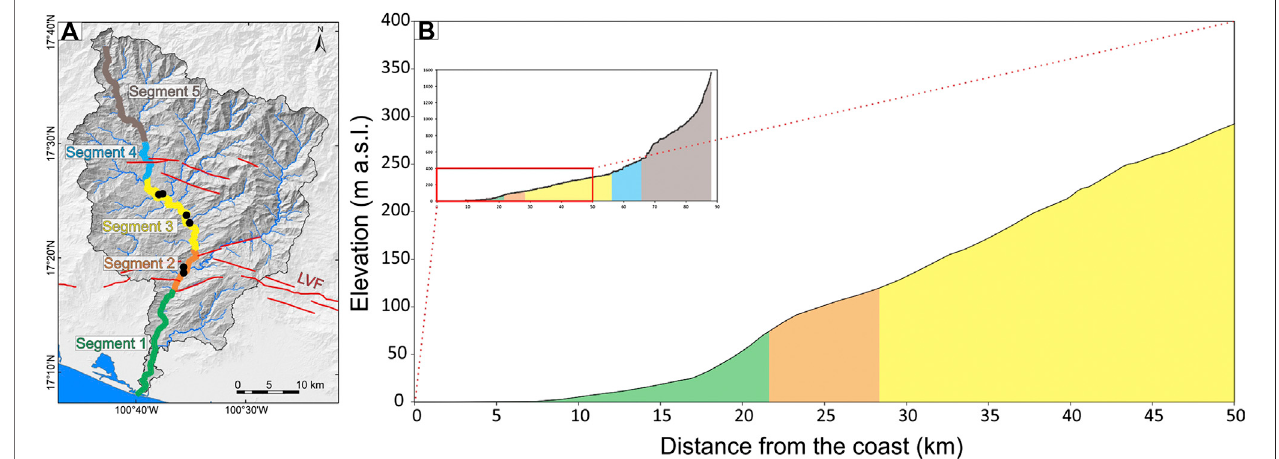
FIGURE2| SegmentationoftheTecpanRiver (A) andriverlongitudinalpro fi le (B) ;colorsonthepro fi lecorrespondtocolorsofsegmentsde fi nedalongtheriver(for details on geomorphometric indices in each segment, see Table 2 ). Black dots show the location of the OSL sampling sites. LVF — La Venta Fault.